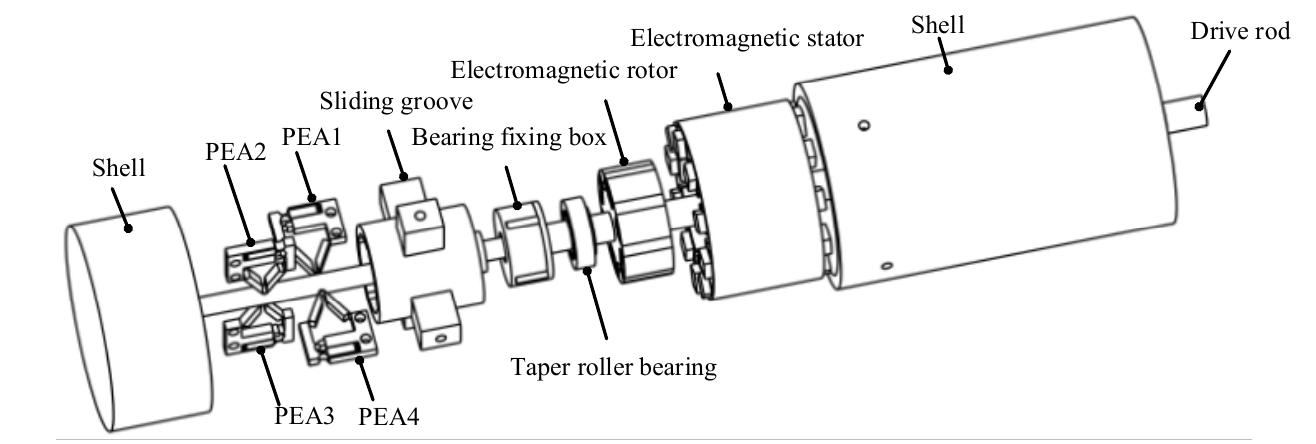
Figure 2. The internal structure of the actuator.